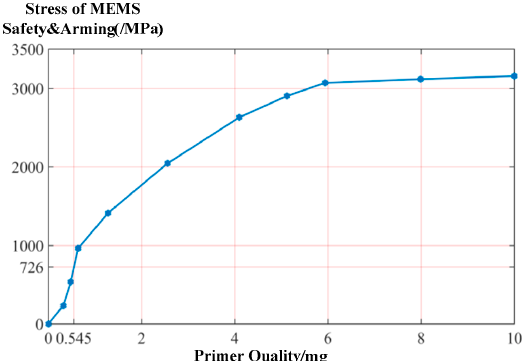
Figure 6. Relation between the maximum stress of the silicon wafers in the denotation field and the amount of copper azide primer.